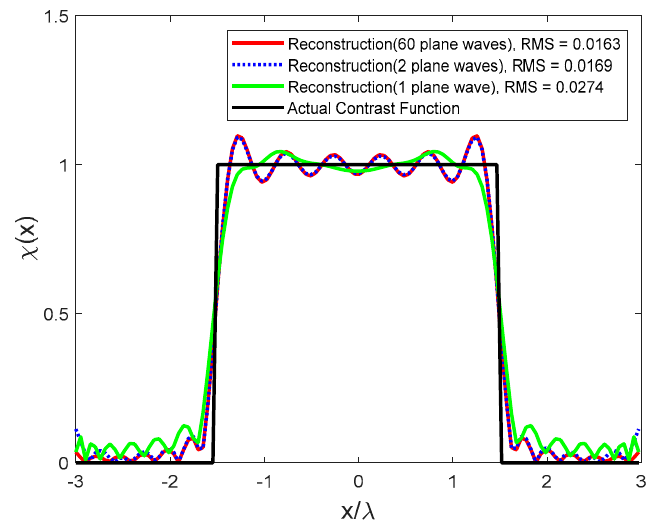
Figure 5. The reconstruction of a strip object.